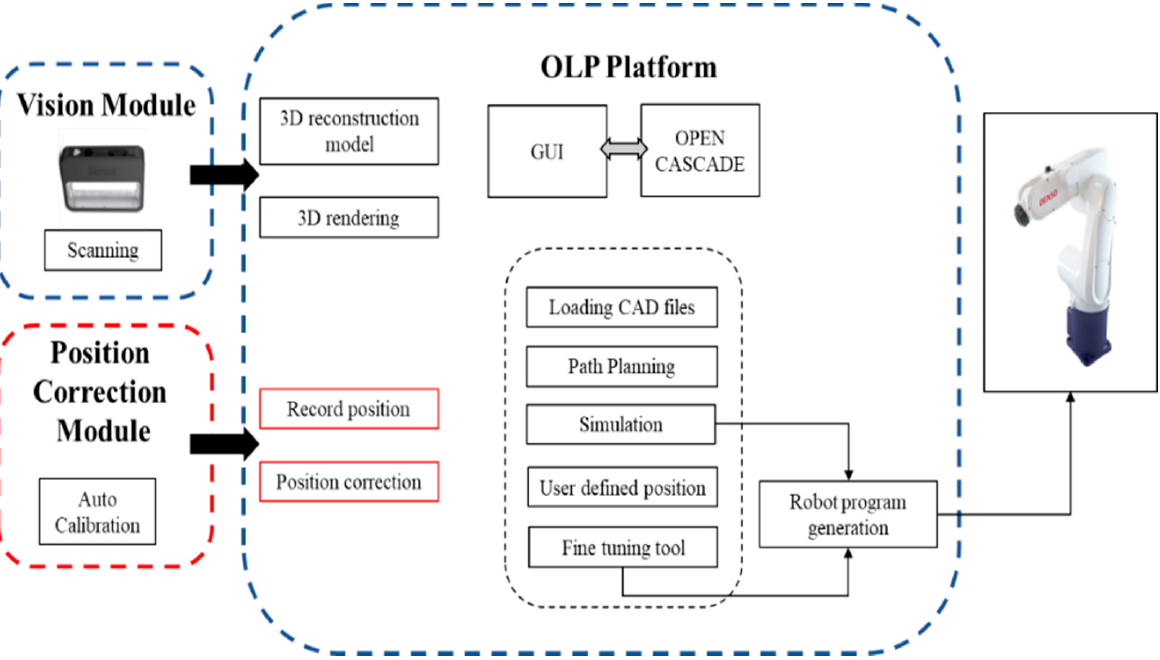
Figure 1. Overview of the position correction module integration with the robot-guided inspection system architecture.